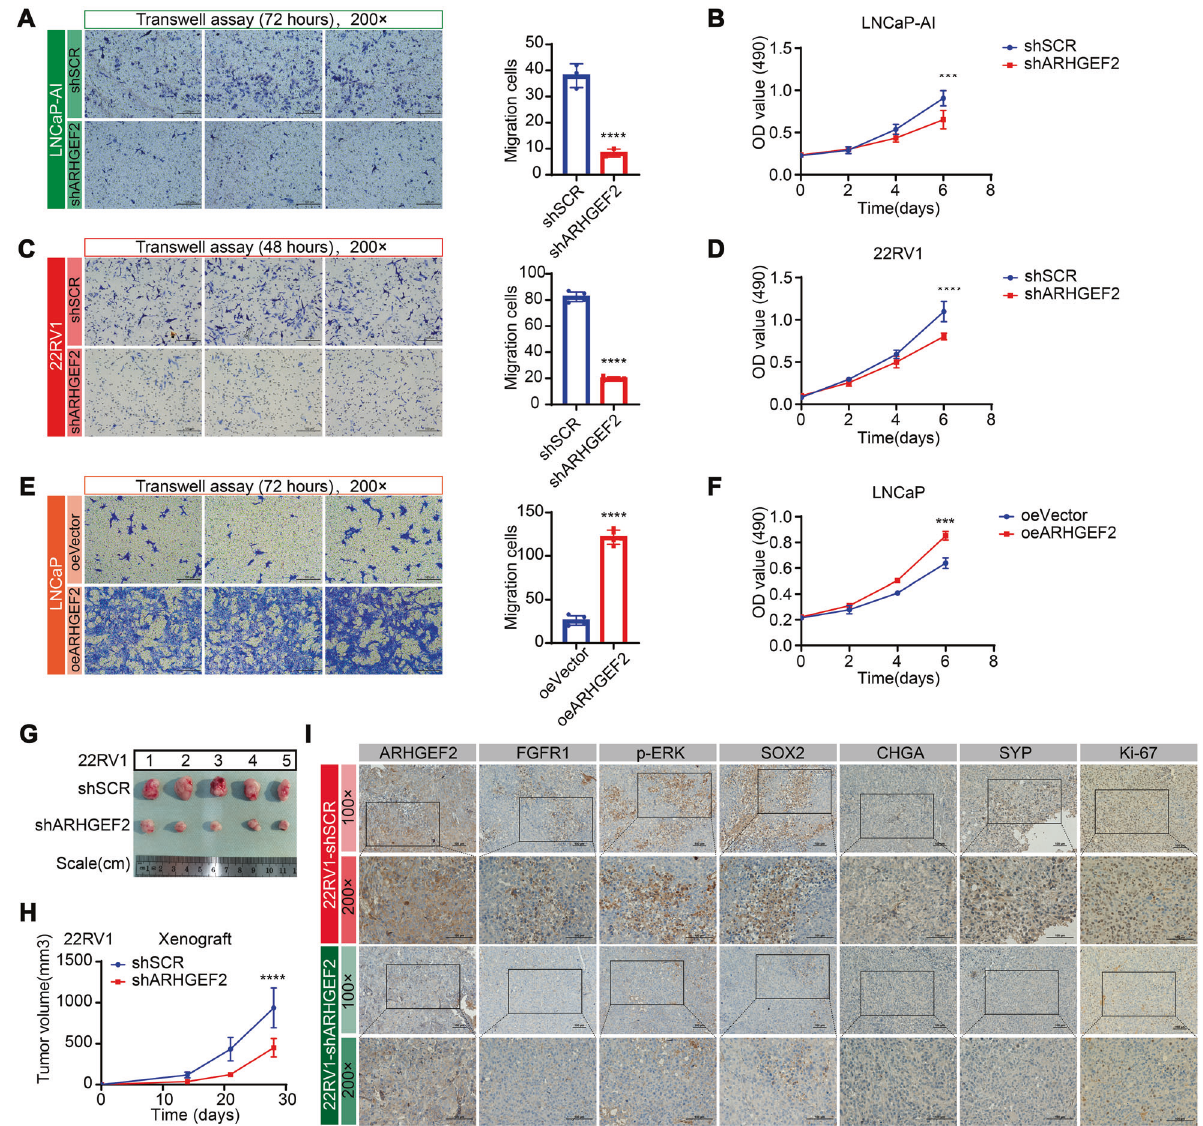
Fig. 6 Targeting ARHGEF2 reduces the tumor growth of prostate cancer cells. A . Transwell migration assay in LNCaP-AI cells infected with lentiviruses carrying shARHGEF2. The left panel shows the representative microphotographs (scale bar = 100 µm). B . MTT assays in LNCaP-AI cells infected with lentiviruses carrying shARHGEF2. Cell growth assessed daily for 6 days using an MTT assay in LNCaP-AI cells. Data were obtained from three independent experiments with samples in triplicate. C . Transwell migration assay in 22RV1 cells infected with lentiviruses carrying shARHGEF2. The left panel shows the representative microphotographs (scale bar = 100 µm). D MTT assays in 22RV1 cells infected with lentiviruses carrying shARHGEF2. Cell growth assessed daily for 6 days using an MTT assay in 22RV1 cells. Data were obtained from three independent experiments with samples in triplicate. E , F . Transwell migration assay E and MTT assays F in LNCaP cells infected with lentiviruses carrying overexpressed ARHGEF2 (oeARHGEF2). G Representative image of the dissected tumors was shown. H Growth curves of xenografts of 22RV1 cells infected with shSCR or shARHGEF2. Data are representative of mean ± SD of n = 5 tumors per group. I Representative image of the dissected tumors was shown. Representative images showing immunostaining (×100 and ×200 magni fi cation) for ARHGEF2, FGFR1, p-ERK, SOX2, CHGA, SYN and Ki-67 in tumor specimens obtained from xenografts. For panels A , C , E two-tailed unpaired Student ’ s t-test; For panels B , D , F , and H , two-way ANOVA, Sidak ’ s multiple-comparisons test was applied. * P ≤ 0.05, ** P ≤ 0.01, *** P ≤ 0.001, and **** P < deletion cell lines (Fig. 5D, E). Similarly, in ectopic overexpression Gain of the Fibroblast Growth Factor Receptor 1 (FGFR1) is of ARHGEF2 LNCaP cells, FGFR1 also exhibit a signi fi cant reported associated with the progression to malignancy in PCa upregulation along with ARHGEF2 overexpression (Fig. 5F). and many other epithelial originating lesions [48]. Our RNA-seq Besides, FGFR1 activation could upregulate SOX2 expression by data show reduced FGFR1expression upon ARHGEF2 deletion, we downstream phosphorylated ERK of MAPK pathway [49]. Our data sought to examine ARHGEF2-mediated regulation of FGFR1 and also show reduced ARHGEF2 expression could downregulate FGFR1/MAPK signaling pathway. We examined the FGFR1expres- FGFR1 and SOX2 expression (Fig. 5D, E), we sought to examine sion in two ARHGEF2 deletion cell lines, and ectopic over- FGFR1-mediated regulation of SOX2. The upregulation of SOX2 by expression of ARHGEF2 LNCaP cells (Fig. 5D – F). Using these cells, ARHGEF2 overexpression was suppressed by FGFR1 inhibitor we observed a remarkable decrease of FGFR1 at ARHGEF2